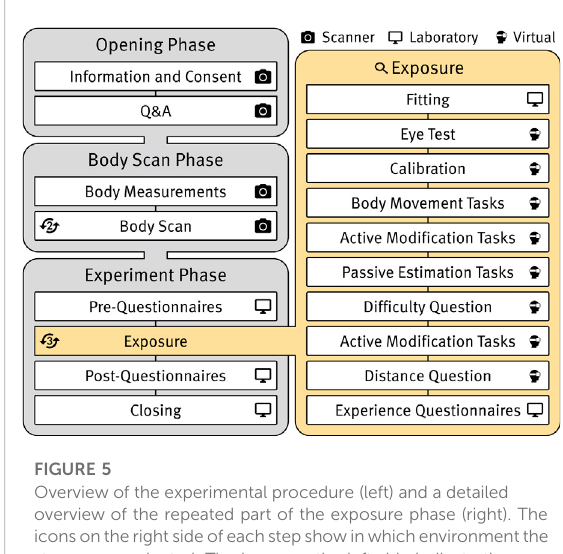
FIGURE 5 Overview of the experimental procedure (left) and a detailed overview of the repeated part of the exposure phase (right). The iconsontherightsideofeachstepshowinwhichenvironmentthe step was conducted. The icons on the left side indicate the repetition of